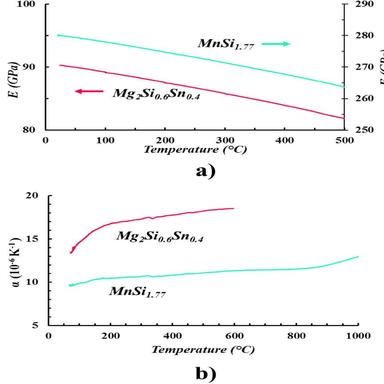
(a) Thermal expansion coefficient vs temperature and (b) Young's modulus vs temperature of MnSi1.77 and Mg2Si0.6Sn0.4.